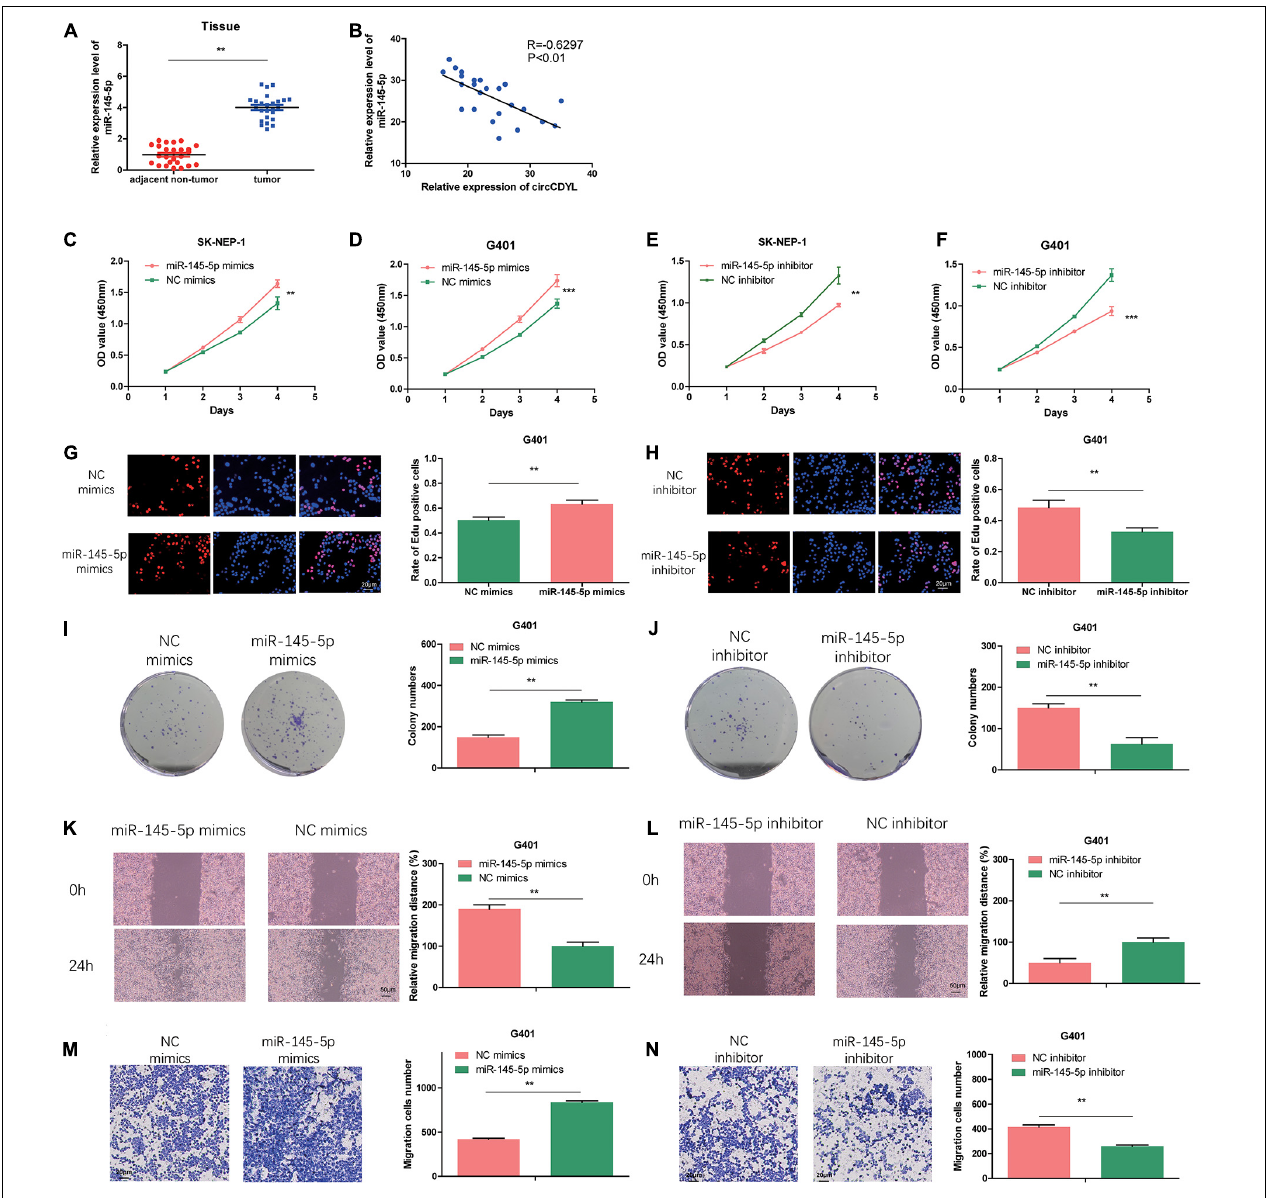
FIGURE 4 | MiR-145-5p enhances proliferation, migration, and invasion in WT cells. (A) The relative expression of miR-145-5p in tumor and adjacent non-tumor tissue by RT-qPCR. (B) The relative expression of miR-145-5p had a negative correlation with circCDYL in the WT tissue. (C–F) The proliferation of SK-NEP-1 and G401 cells transfected by miR-145-5p mimics, miR-145-5p inhibitor, and their controls by the CCK-8 method. (G–J) The proliferation of G401 cells transfecting miR-145-5p mimics, miR-145-5p inhibitor, and their controls by EdU and colony formation assays. (K–N) The migration and invasion ability of G401 cells transfecting miR-145-5p mimics, miR-145-5p inhibitor, and their controls by wound healing assays and transwell assays. Data represent the mean ± SD from three independent experiments. Student’s t -test with two biologically dependent or independent replicates was used to determine statistical significance; *** P < 0.001, ** P < 0.01, * P <